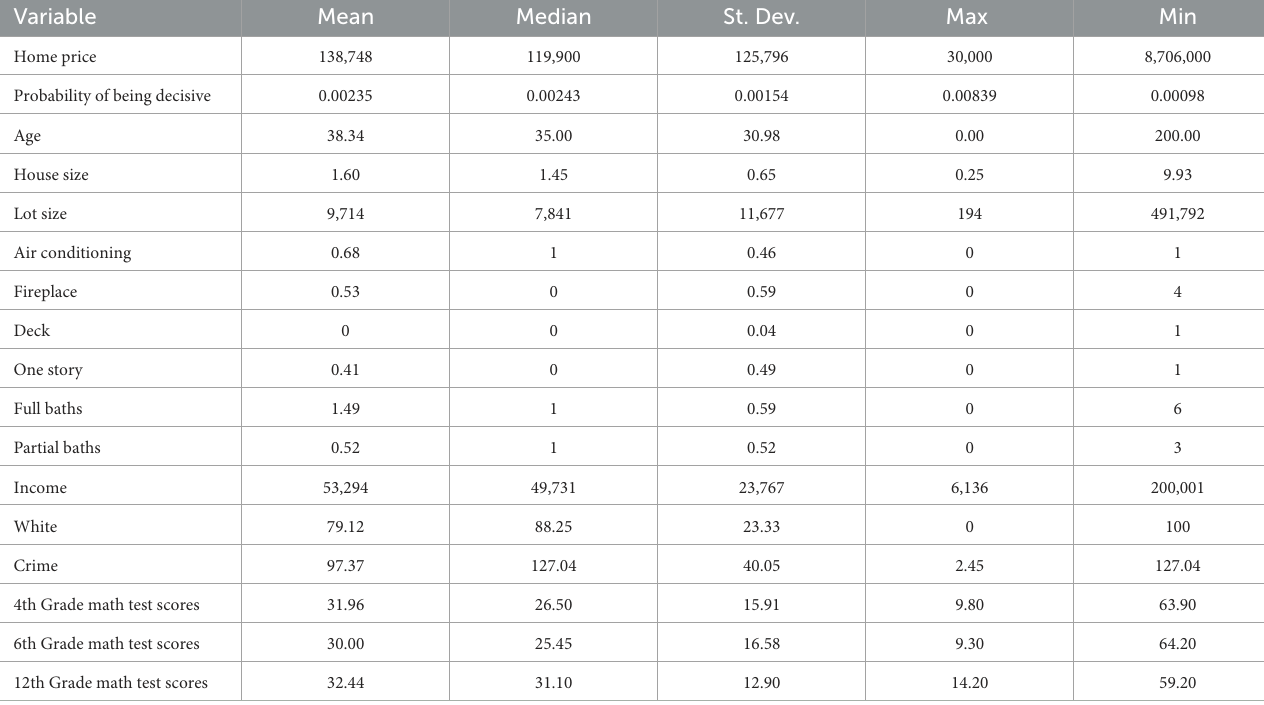
TABLE 2 Summary statistics for Columbus, Ohio hedonic data